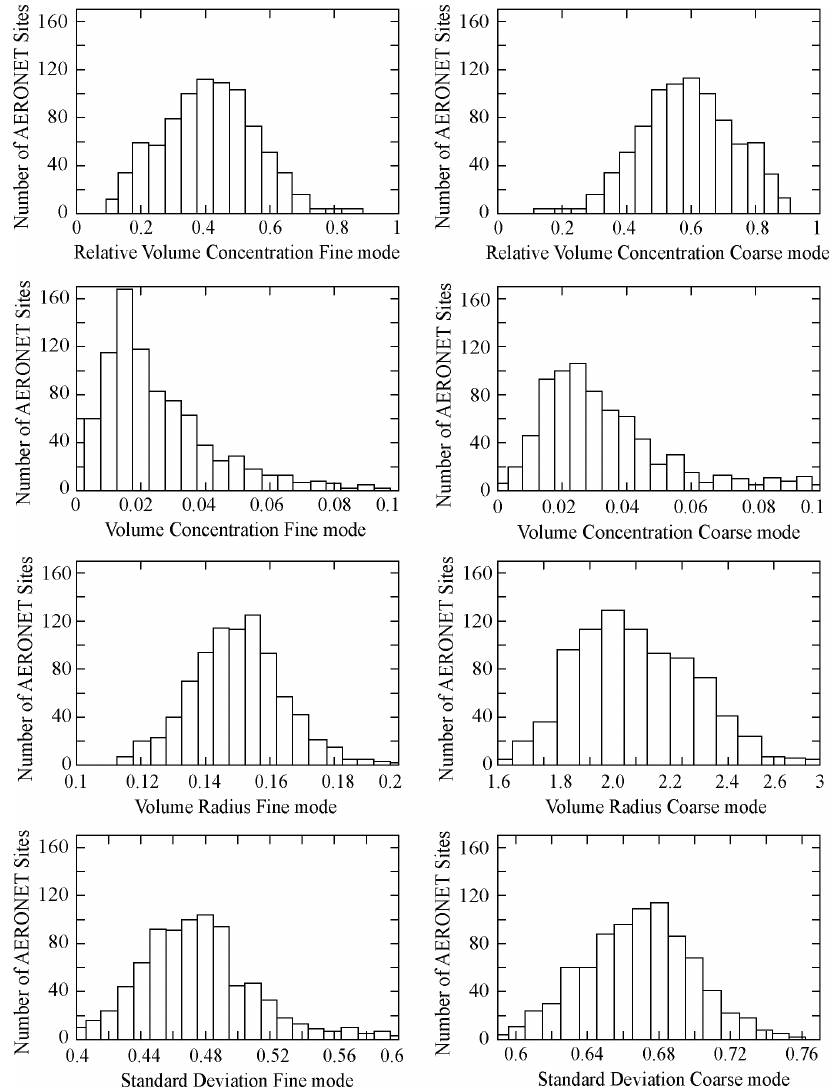
Figure 6. Size distribution parameter frequency for the fine mode (left) and the coarse mode